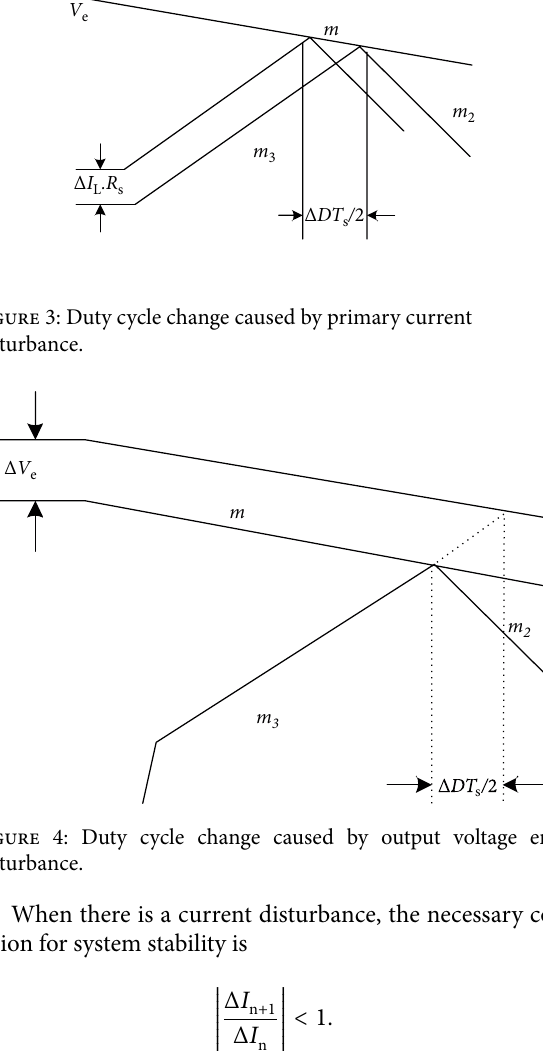
Figure 6: BODE diagram before and after